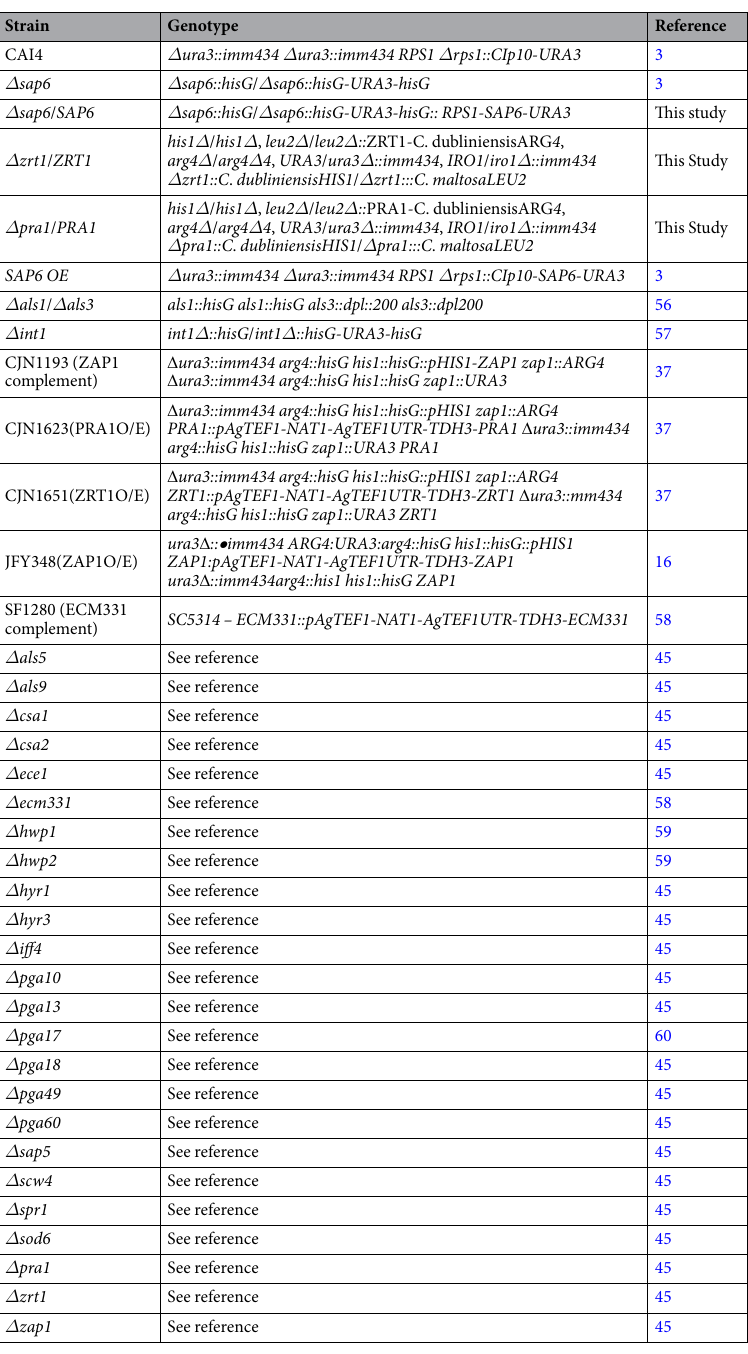
Table 1. C . albicans strains used in this